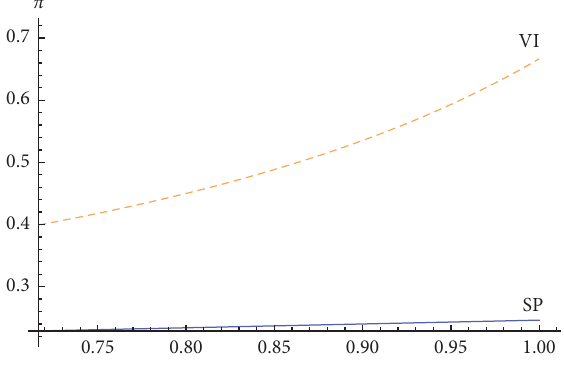
Figure 9: Proft comparison(p2 < p1).